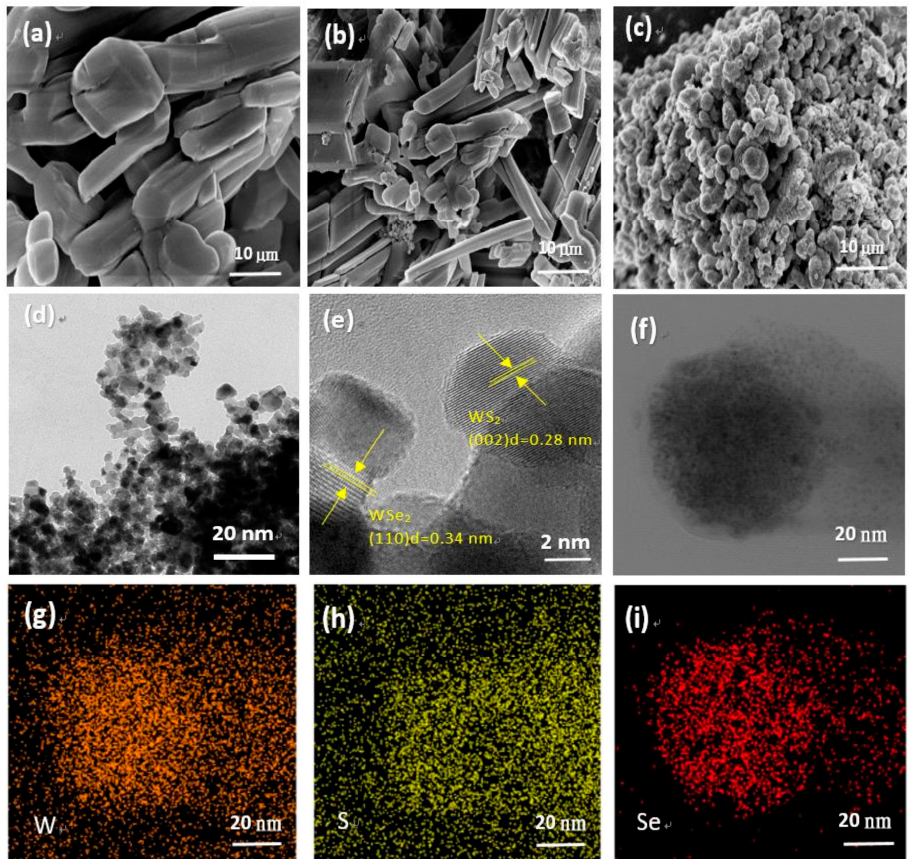
Figure 2. SEM images of ( a ) WS 2 , ( b ) WSe 2 , and ( c ) WS 2 /WSe 2 -20, TEM images of ( d ) WS 2 /WSe 2 -20; HRTEM images ( e ) and element mapping images ( f – i ) of WS 2 /WSe 2